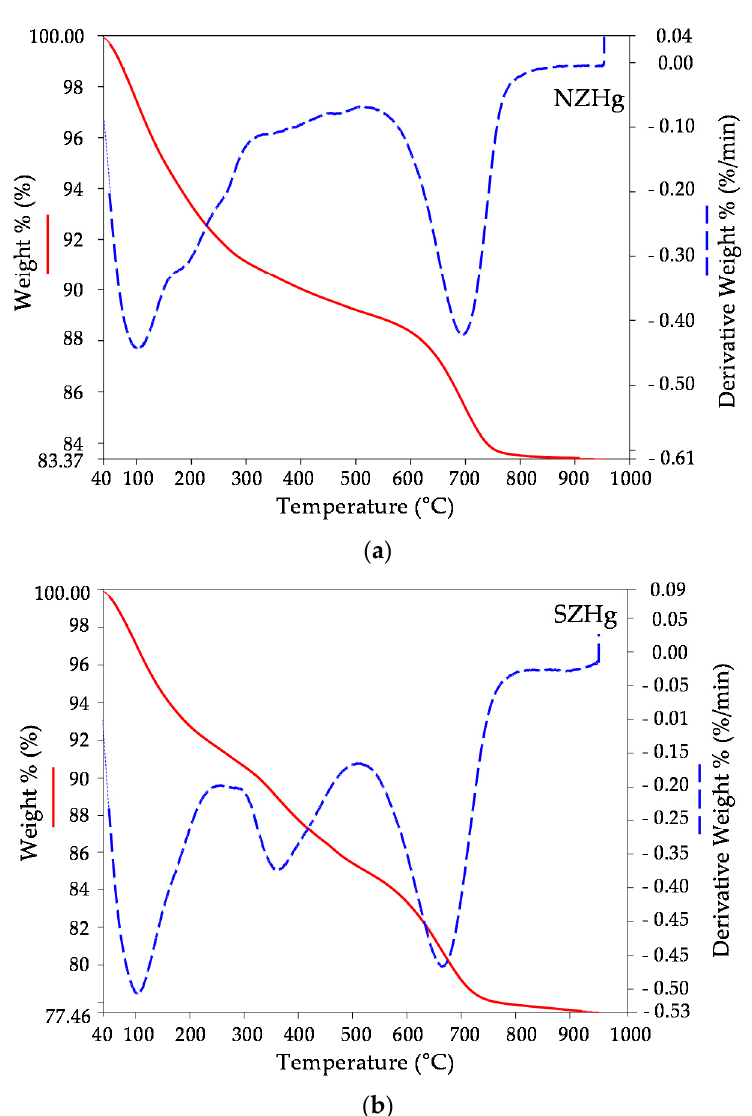
Figure 18. TG-DTG curves for (a ) NZHg and ( b ) SZHg. It can be observed that both saturated samples show similar mass loss in the same temperature range up to 300 °C. Above 300 °C, the significant mass loss at 600–800 °C for NZHg can be attributed to dehydroxylation and volatilization of mercury complexes.